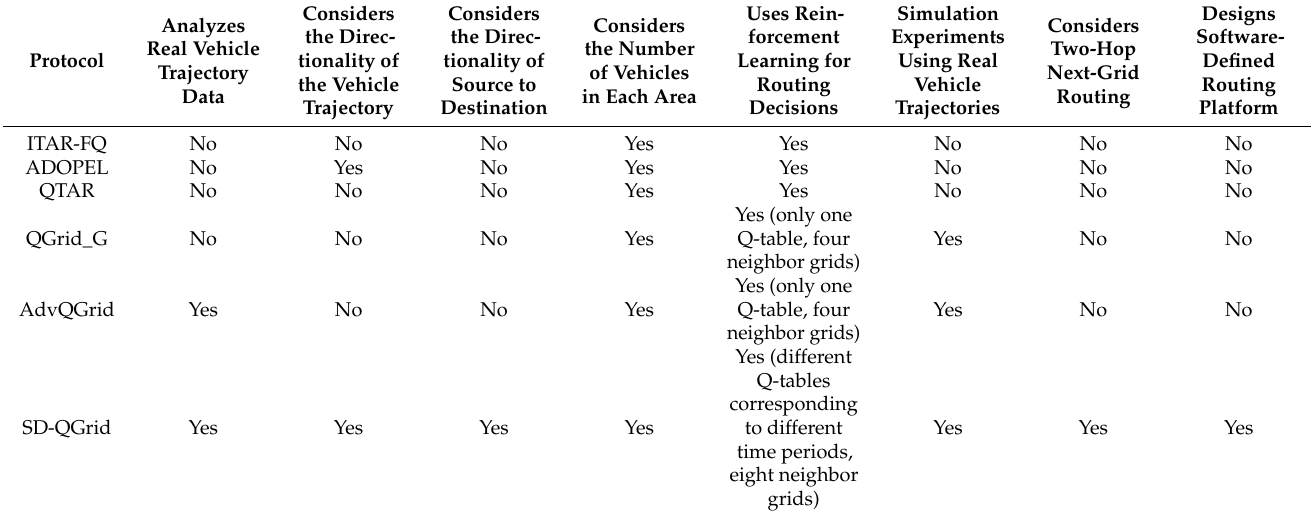
Table 1. Comparison of related